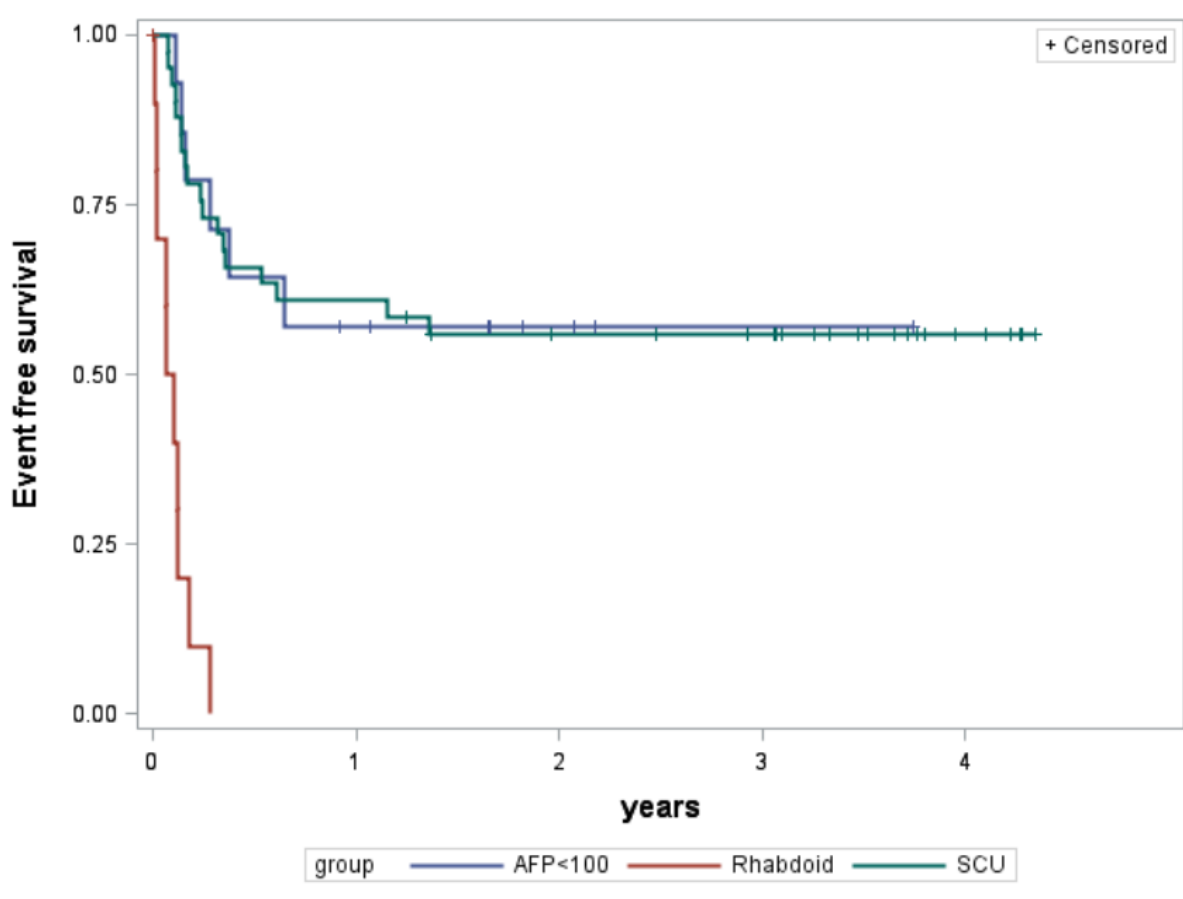
Figure 3. Overall survival in years by group. AFP, alpha-fetoprotein; HB, hepatoblastoma. 3.2. HBs with SCU Component Forty-one patients were diagnosed with HB with SCU component and not classified as rhabdoid tumors, and none had documented loss of SMARCB1 expression by INI1 im-